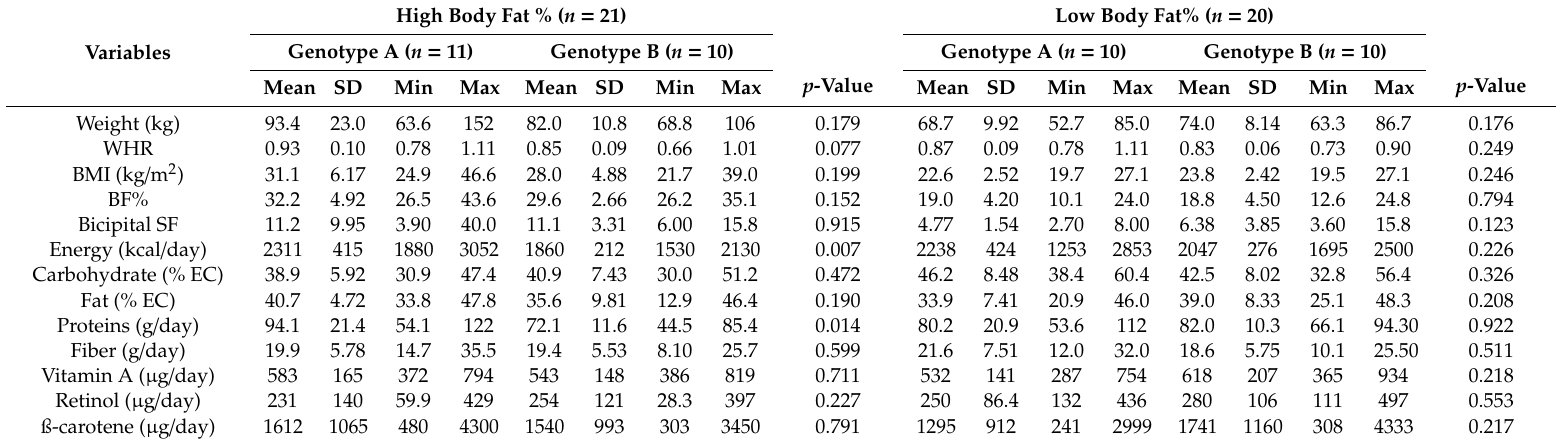
Table 4. Anthropometric and dietary parameters by body fat % (High BF ≥ 25% or Low BF < 25%) and genotype groups (A, Responsive to VA; B, Less responsive to VA) of the OptiDiet-15 cohort 1